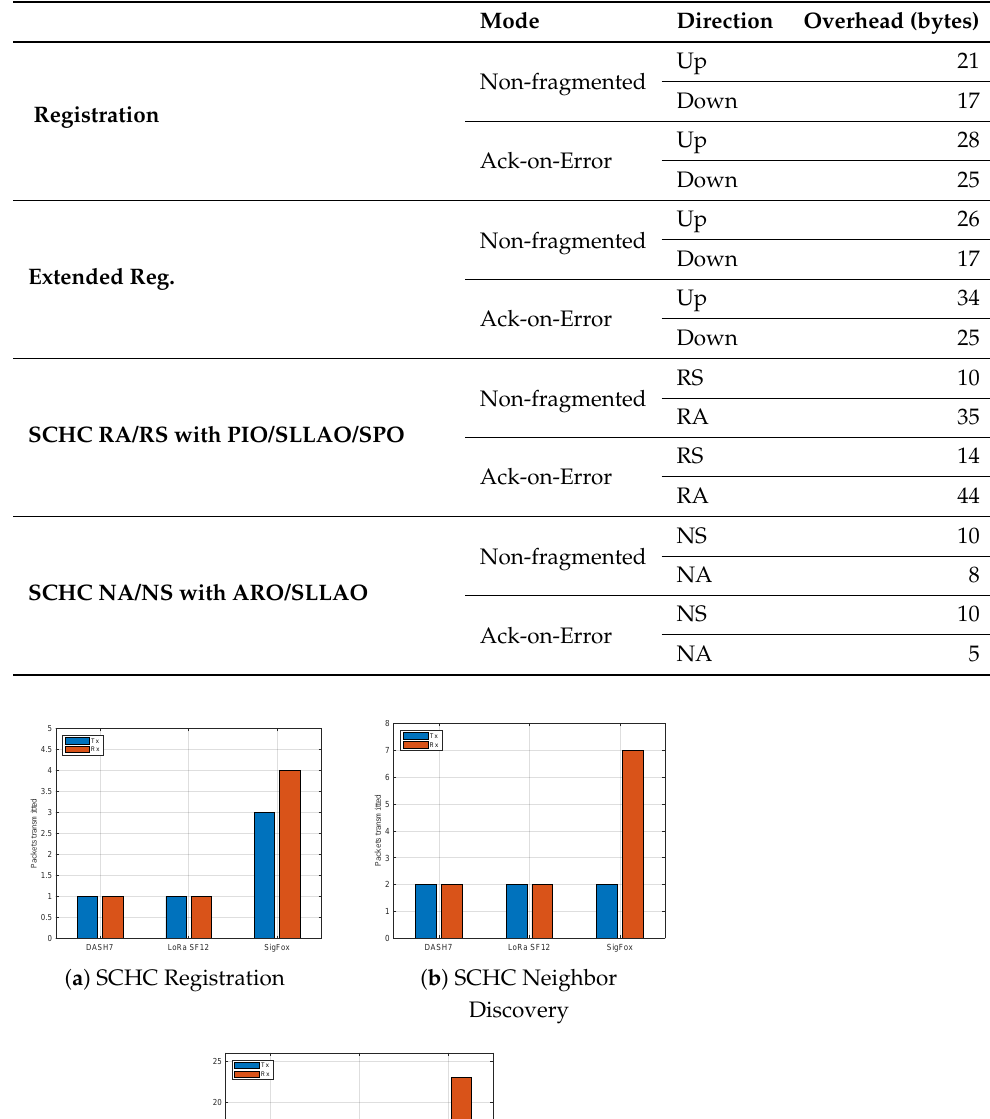
Table 3. Overhead in bits for the proposed specifications. The Non-fragmented mode is used for a LoRa SF12 device, while the Ack-on-Error mode is used for a Sigfox device.